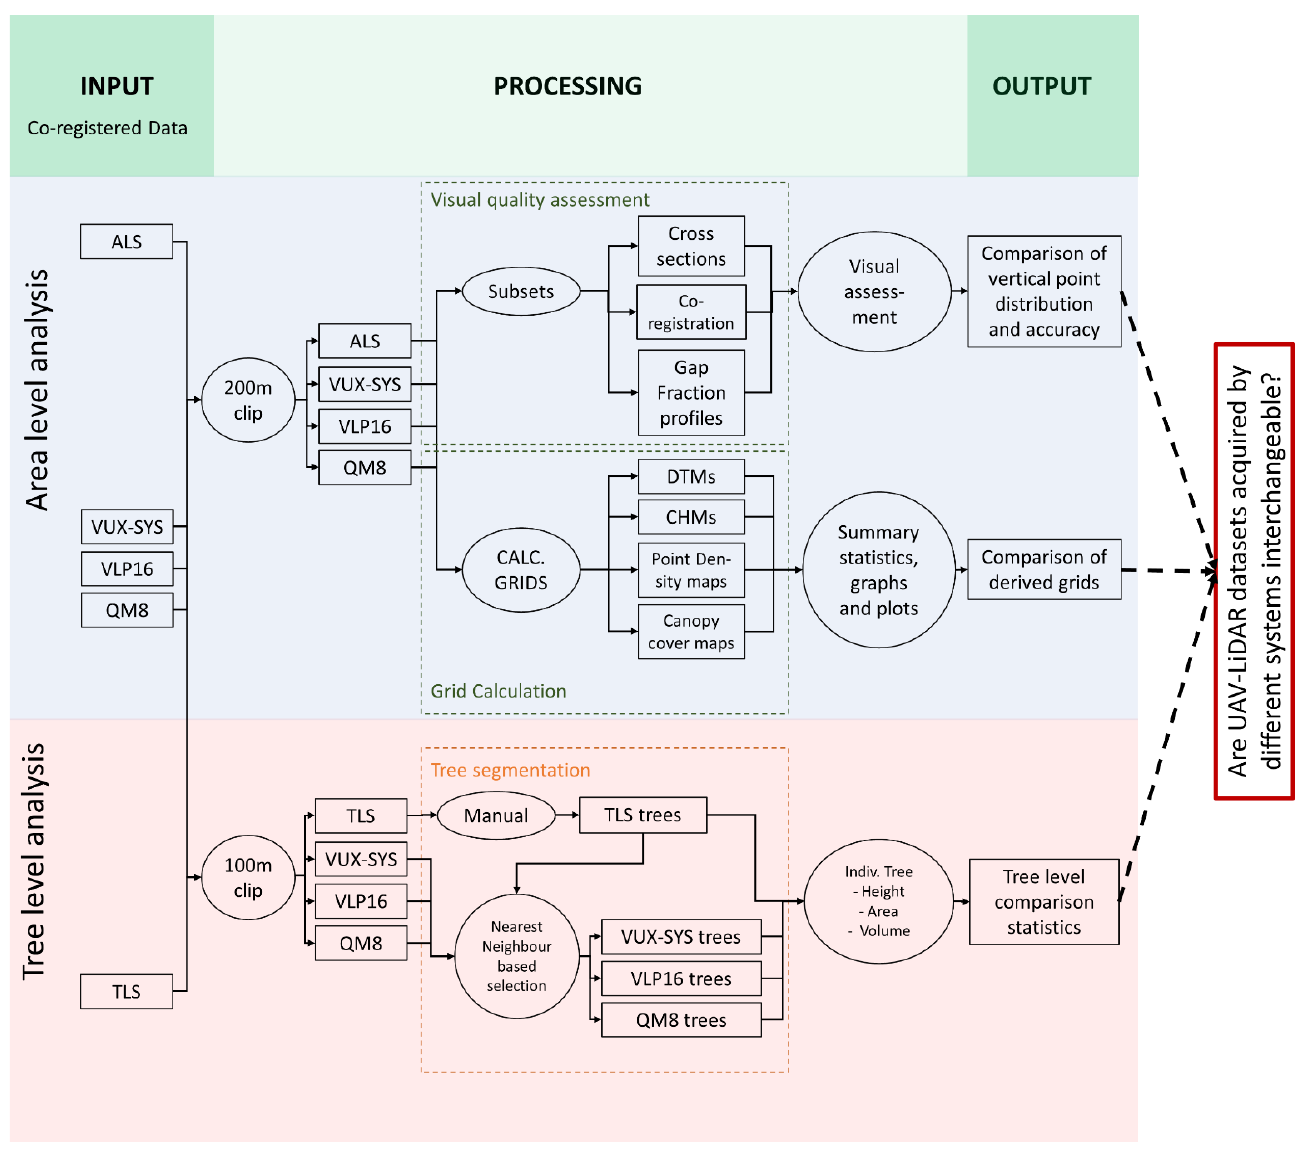
Figure 2. Flowchart of the followed methodology.